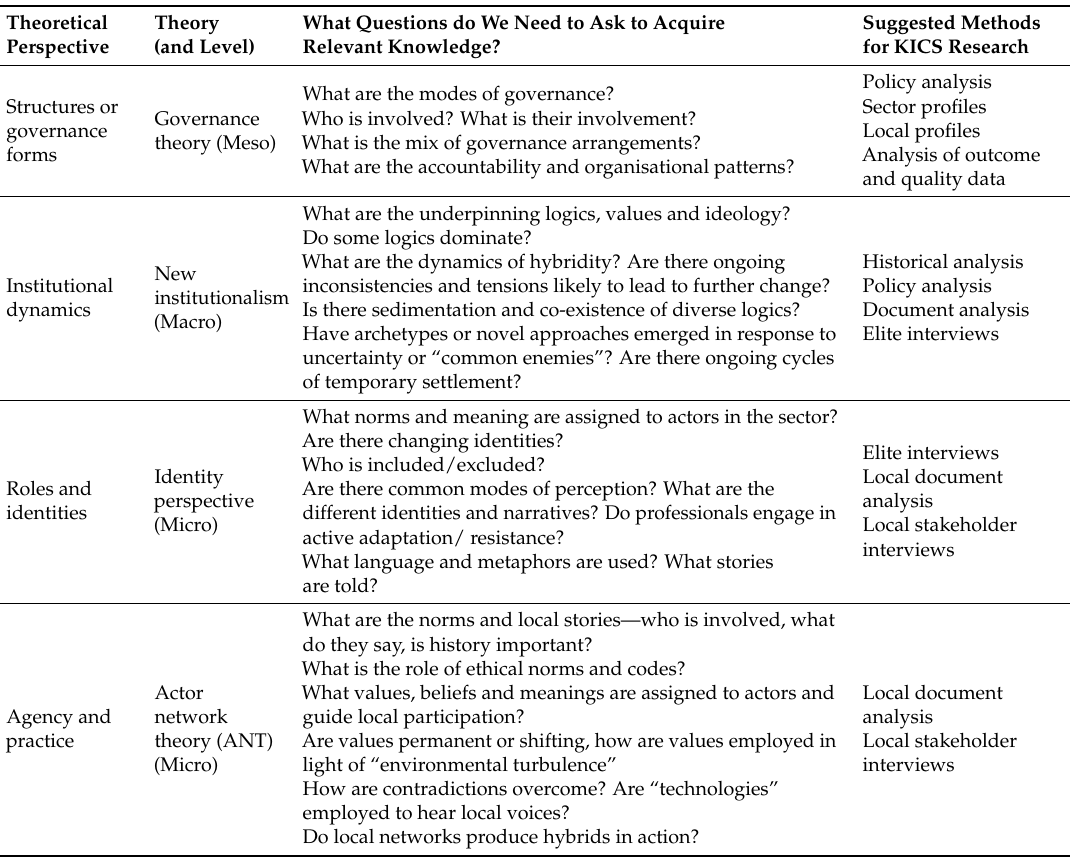
Table 1. Theoretical perspectives, questions and methods to interrogate hybridity in kids in communities study (KICS)